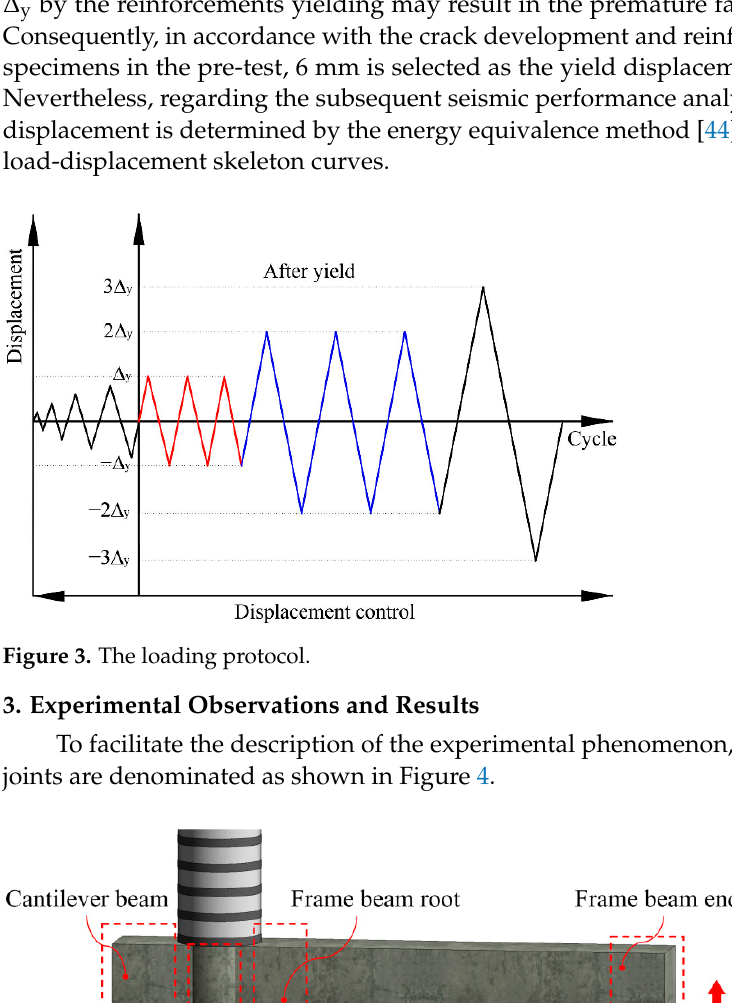
5 of 21 Figure 2. The loading and measurement device.